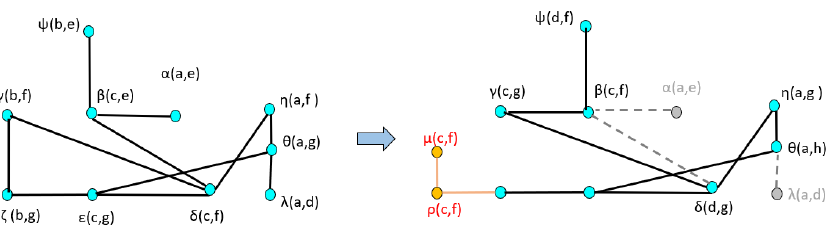
Figure 24. Dual graph representation and comparison of joint vocabulary between model M 1 and model M 2 .